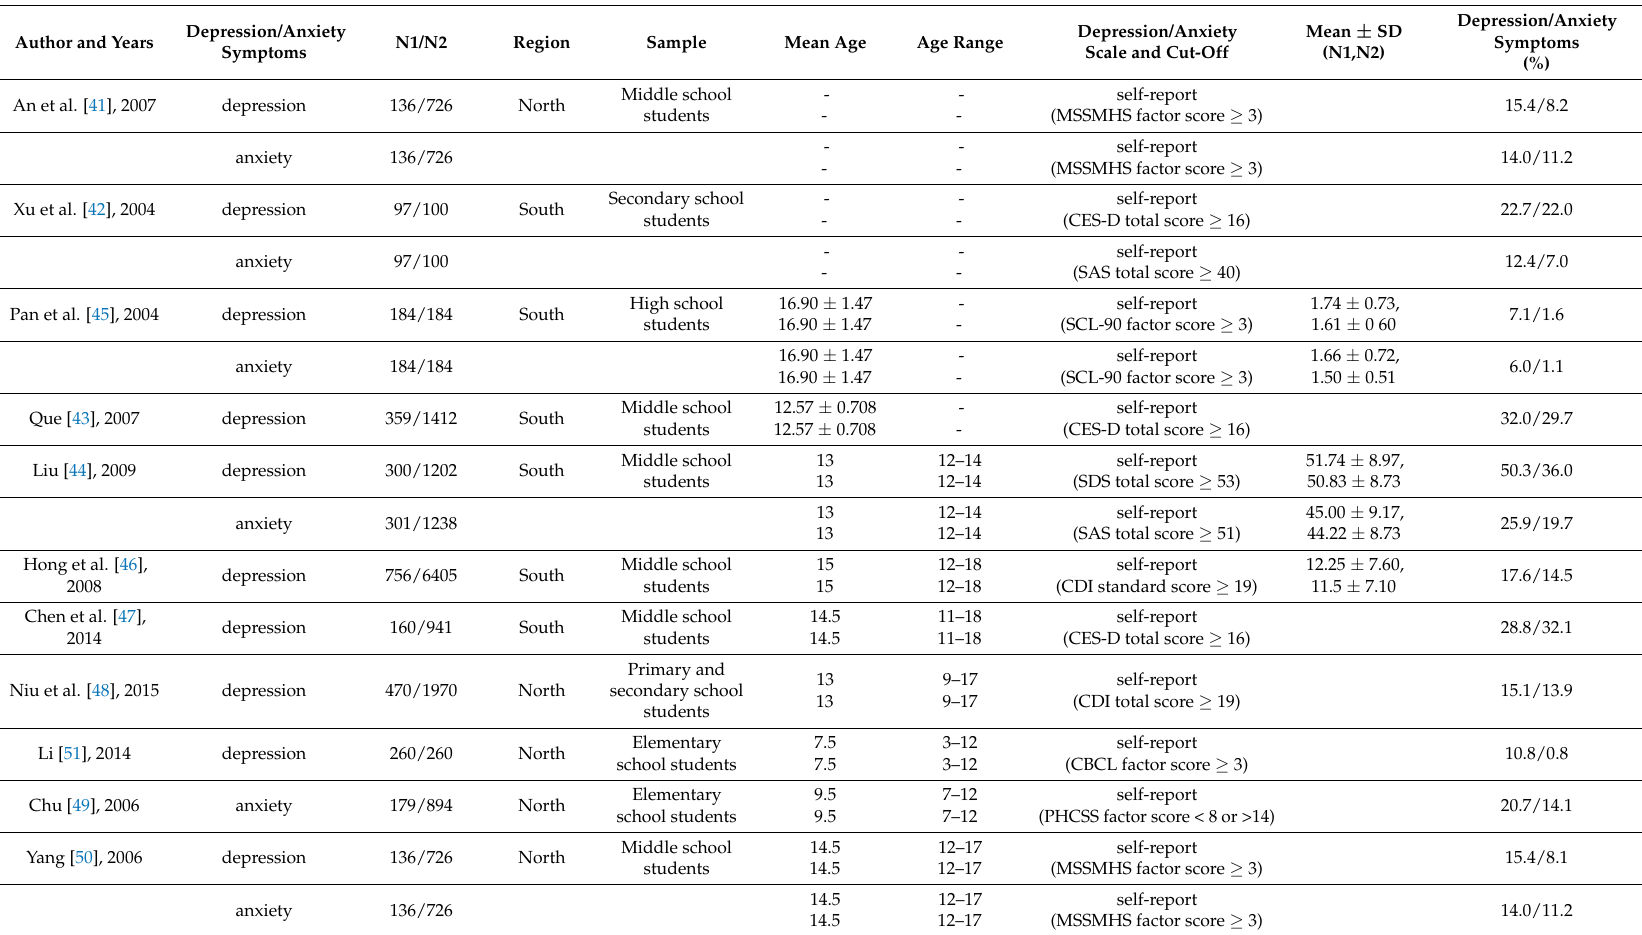
Table 1. Characteristics of inclusion in the